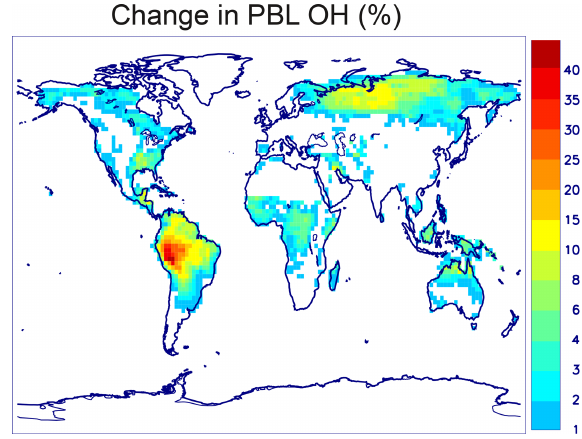
Figure 7. Calculated change (in %) in boundary layer OH concen- tration upon inclusion of isomerization reactions of isoprene peroxy radicals (column average, July 2013).